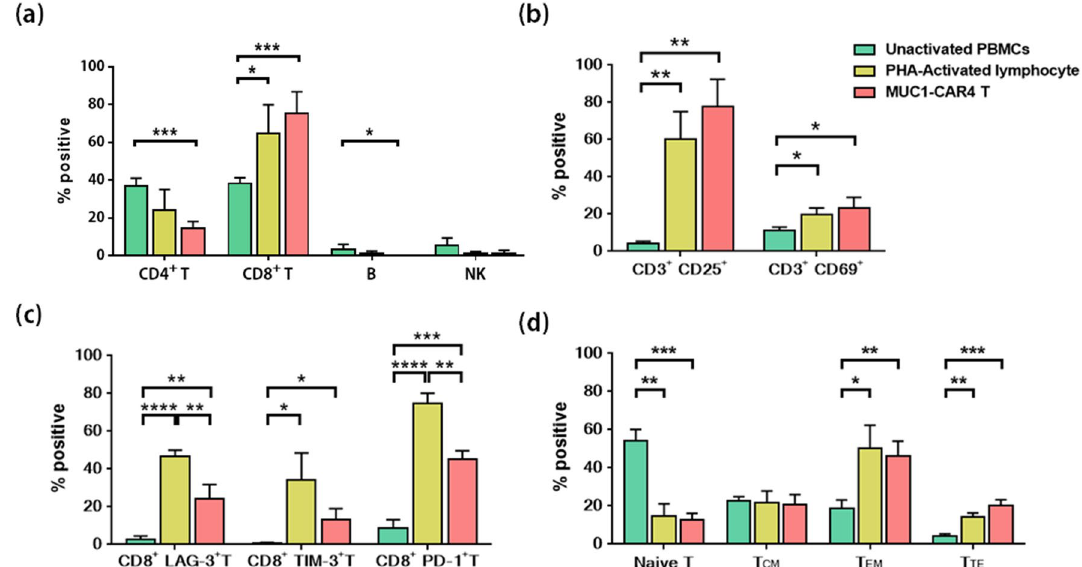
Figure 4. Phenotypes, activation and exhaustion markers, and memory subsets of anti-MUC1-CAR4 T cells analyzed by flow cytometry. The phenotypic analyses of unactivated PBMCs (green), PHA-activated lymphocyte (yellow), and anti-MUC1-CAR4 T cells (red) were summarized: ( a ) cellular phenotypes (n = 4, mean ± SD); ( b ) activation markers (CD25 and CD69) (n = 3, mean ± SD); ( c ) exhaustion markers (LAG-3, TIM-3, and PD-1) (n = 3, mean ± SD); and ( d ) memory subsets (n = 5, mean ± SEM). The statistical differences were analyzed by Student t -test (asterisks represent p -values: * p < 0.05, ** p < 0.01, *** p < 0.001, **** p <